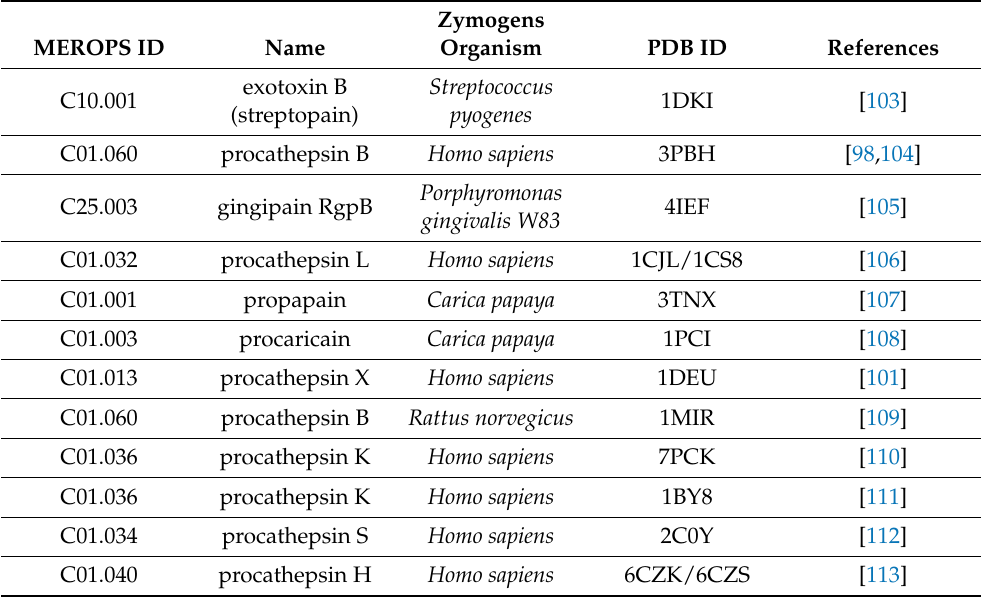
Table 4. List of the available structures of the complexes between protein inhibitors and cysteine proteases: